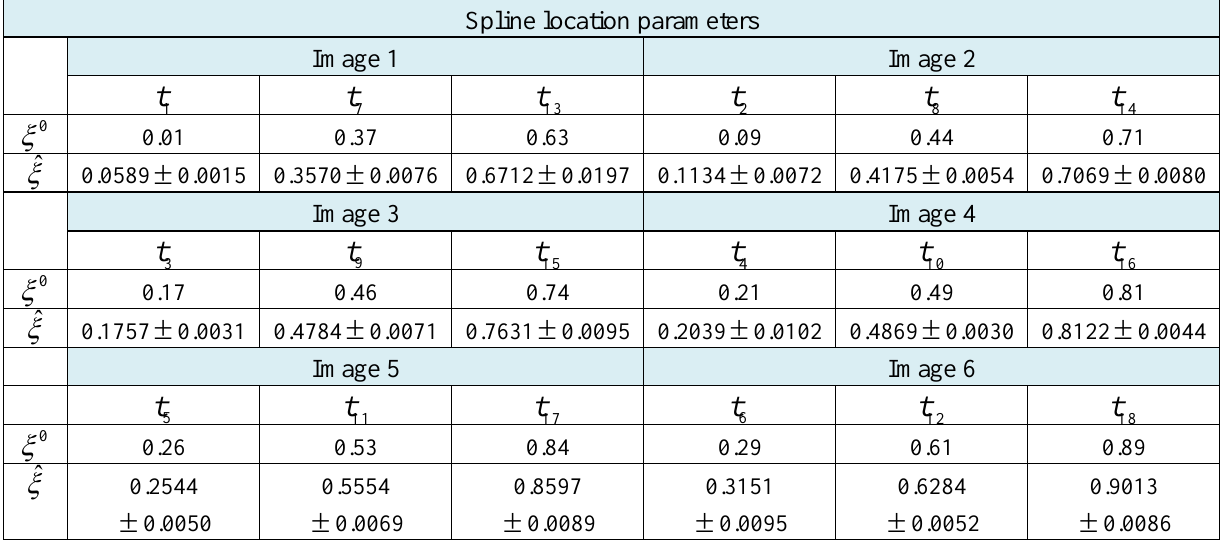
Table 5. Spline location parameter